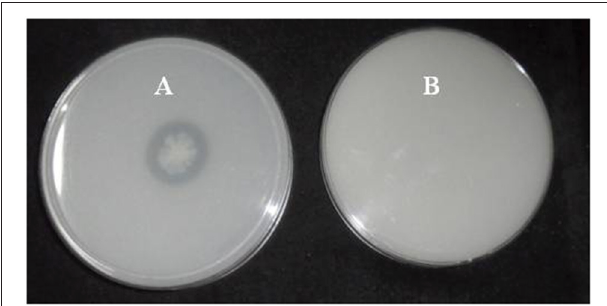
FIGURE 1 | Clear zone formation by Brevibacterium sp. SOTI06. The bacterium forms a clear zone around the colony on DB medium in the presence of CaCO 3 (A) indicating calcite dissolution was compared with control plate (B)